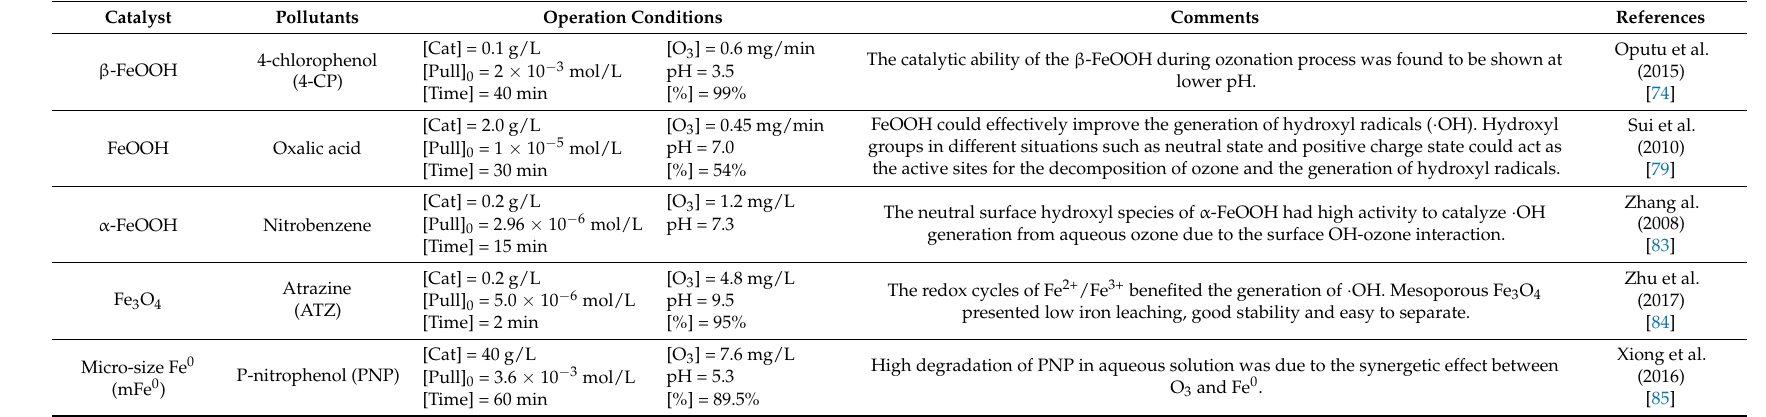
Table 5. Iron oxides for catalytic ozonation